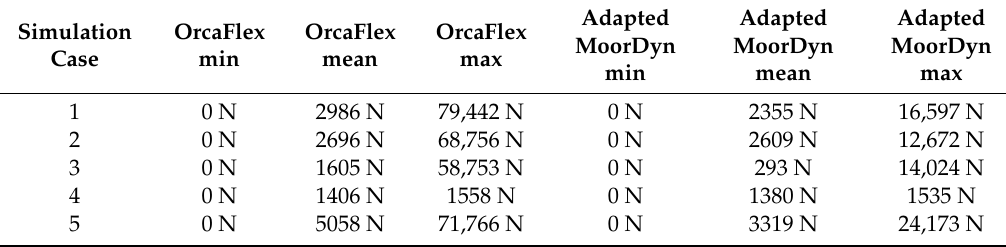
Table 7. Summary of anchor tension for all simulation cases.